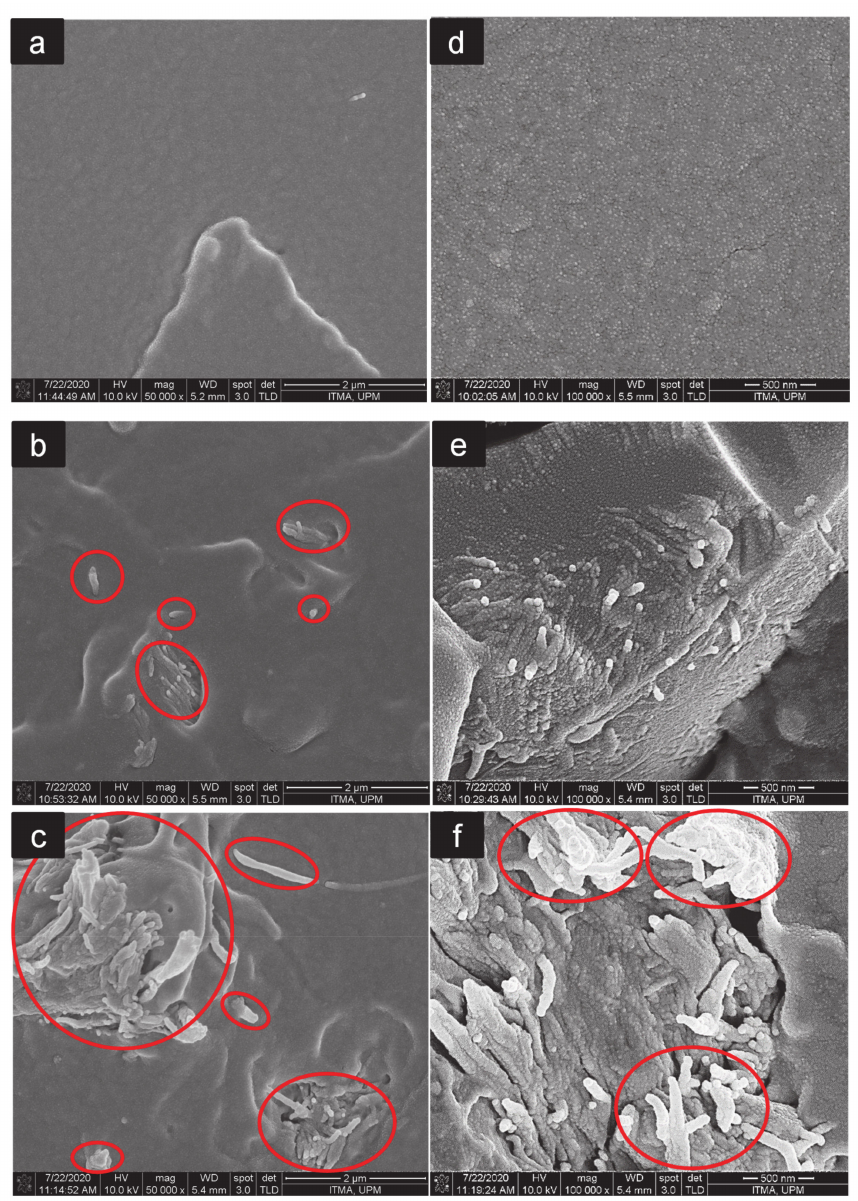
Figure 7. FESEM viewing at 50,000 × and 100,000 × magnification of the fractured surfaces of neat PLA ( a , d ), PLA/CNF3 ( b , e ), and PLA/CNF6 ( c , f ). Red circles show cellulose nanofibrils. PLA/CNF6 exhibits agglomerated